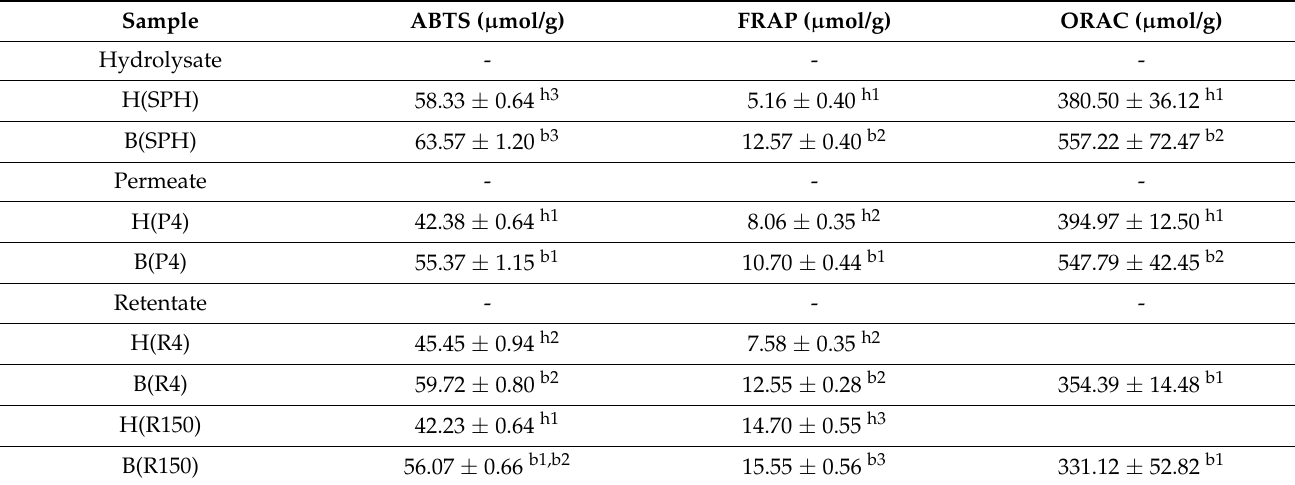
Table 2. Antioxidative activity (x ± SEM, n = 12) of saithe protein hydrolysates (SPH), permeates (P4), and retentates (R4, R150) after membrane filtration with a 150 kDa cut-off ceramic membrane and 4 kDa cut-off PESH membrane. SPH were obtained from enzymatic hydrolysis of saithe heads (H) and backbones (B). Results from ABTS are given as µ mol/g propyl gallate equivalents, FRAP, and ORAC are given as µ mol/g Trolox equivalents. Results of Tukey’s post hoc grouping are indicated (H: h1–3, B: b1–3) for the individual